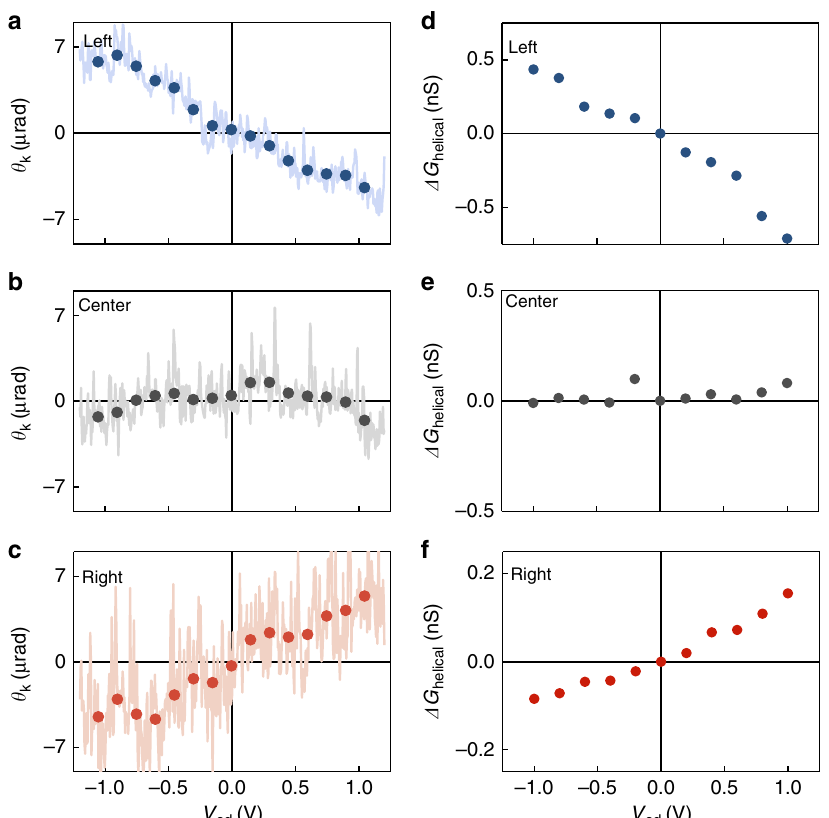
Fig. 4 Kerr angle and helical photoconductance vs. bias voltage. a – c Kerr angle θ k vs. the applied bias V sd at the left edge ( a ), center ( b ), and right edge ( c ) of a BTS platelet ( P laser = 400 µ W). d – f Corresponding Δ G helical vs. the applied bias V sd ( P laser = 230 µ W). All measurements are performed at room